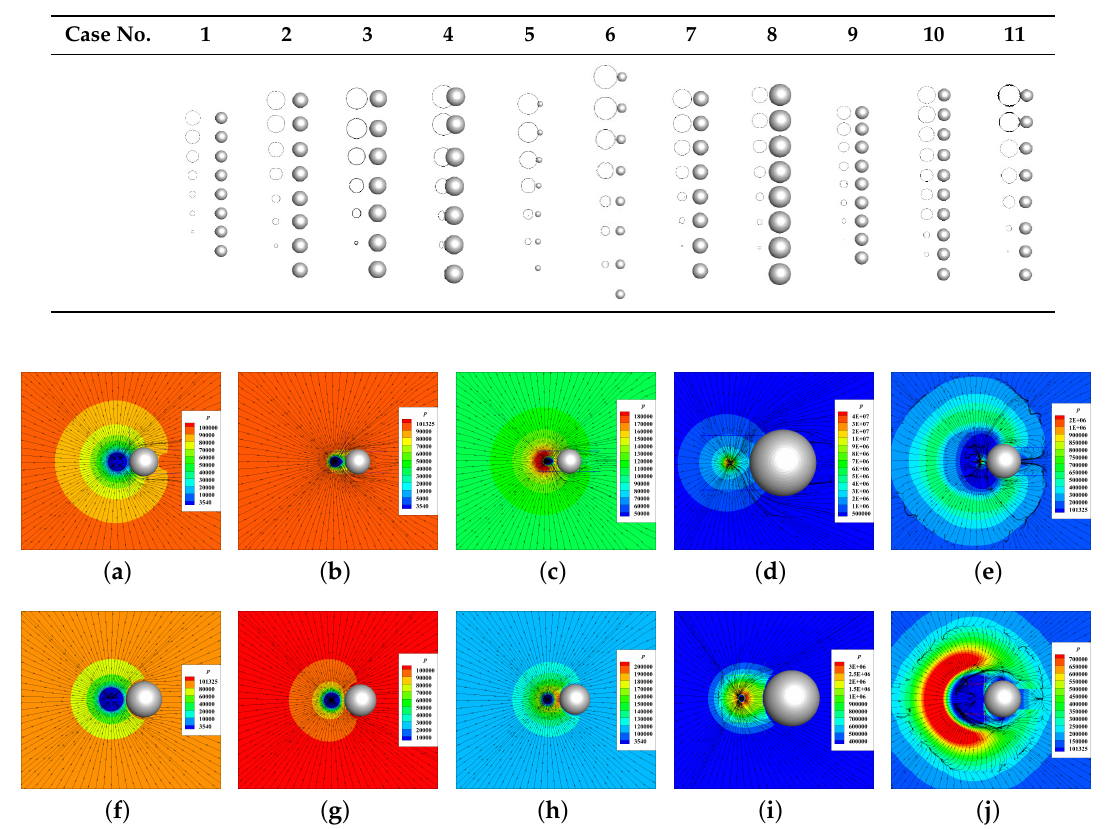
Table 3. The profiles of collapsing bubbles under the influence of movable particles in simulations of cases in Table 2.